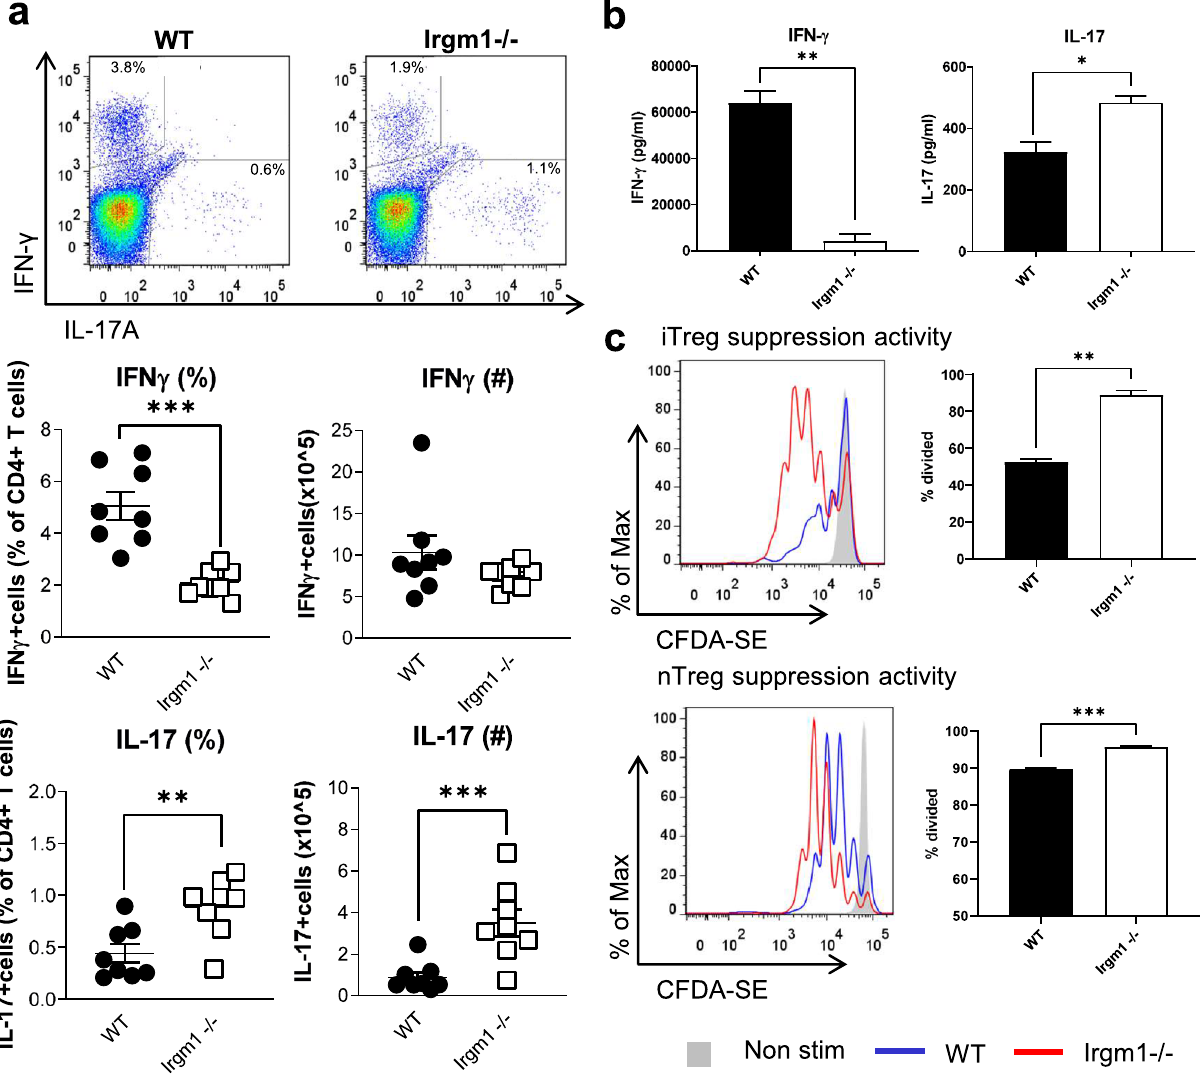
Figure 2. Irgm1 deficiency is associated with effector and regulatory CD4 + T cell dysfunction. ( a ) Splenocytes were isolated from WT and Irgm1 −/− mice, stained and analyzed by flow cytometry for CD4 + IFNγ + and CD4 + IL-17 + Cells. ( b ) CD4 + T cells were isolated and activated for 48 h with plate bound anti-CD3 and anti-CD28 antibodies, after which the media was collected and IFNγ and IL-17A were measured by ELISA. ( c ) Isolated induced Treg cells or natural Treg cells from WT and Irgm1 −/− mice were co-cultured for three days with WT CD8 + T cells stained with CFDA cell tracer. Treg suppressive capacity was analyzed by the ability to reduce proliferation of CD8 + T cells, as measured by the dilution of the fluorescent dye flow cytometrically (The CD8:Treg ratio for the data shown is 1:1 for iTregs and 1:5 for nTregs). Each dot represents a single mouse. (a) data pooled from two independent experiments ( n = 8 ), (b,c) data are representative of two independent experiments ( n = 3–6 ); error bars represent ± SEM. Mann Whitney test or T-test with Welch’s correction was used to compare groups depending on the normality of the distribution as judged by the Shapiro–Wilk test. * p < 0.05, ** p < 0.01, *** p < 0.001. **** p <